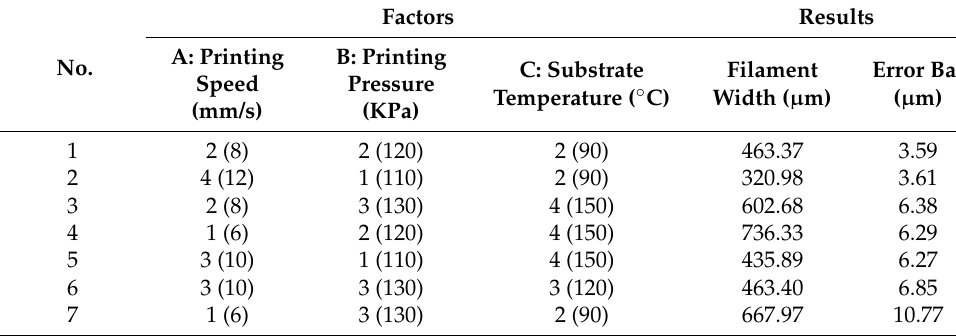
Table 3. Orthogonal experiment parameters, results, and range